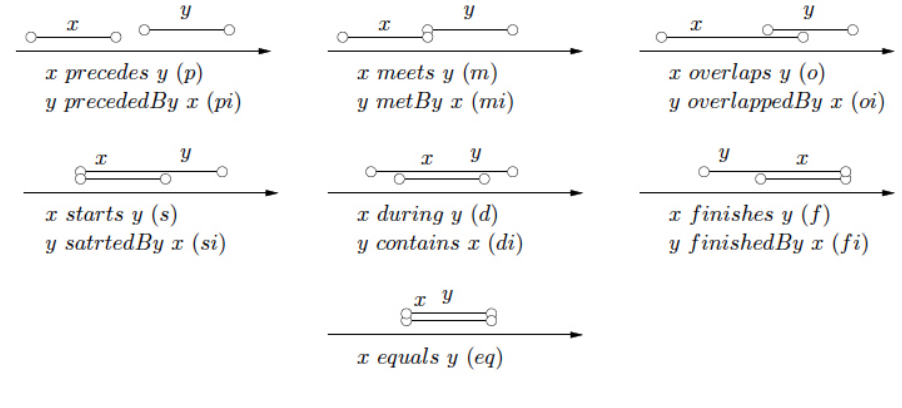
Figure 3. Allen’s intervals algebra atomic